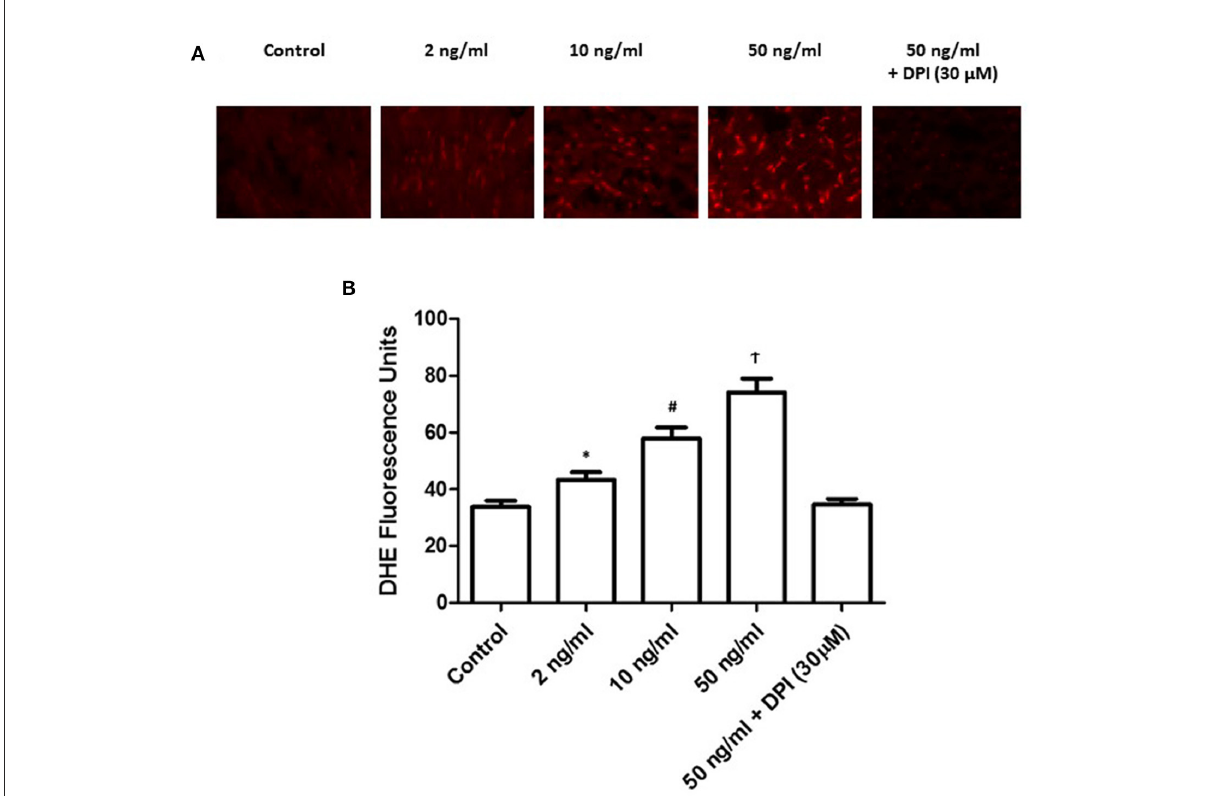
FIGURE5 PDGF-BB stimulation increased the formation of H 2 O 2 under a dose-dependent manner. (A) Representative images of DHE staining were shown. (B) Quantification of the fluorescence intensity was calculated. Under different concentration of PDGF-BB, H 2 O 2 level increased significantly with the increase of PDGF-BB ( P < 0.05). N = 4–6. * P < 0.05 vs. control; # P < 0.05 vs. 2ng/ml group; † P < 0.05 vs. 10ng/ml group.